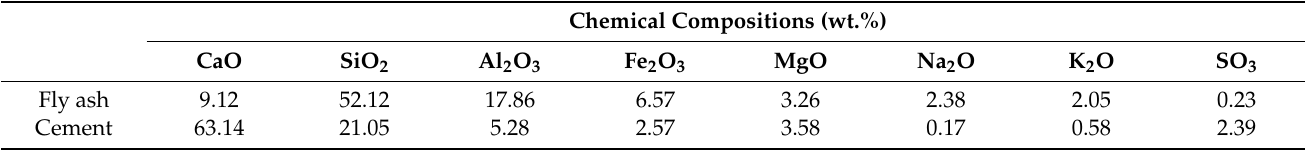
Table 1. Chemical compositions of fly ash and cement